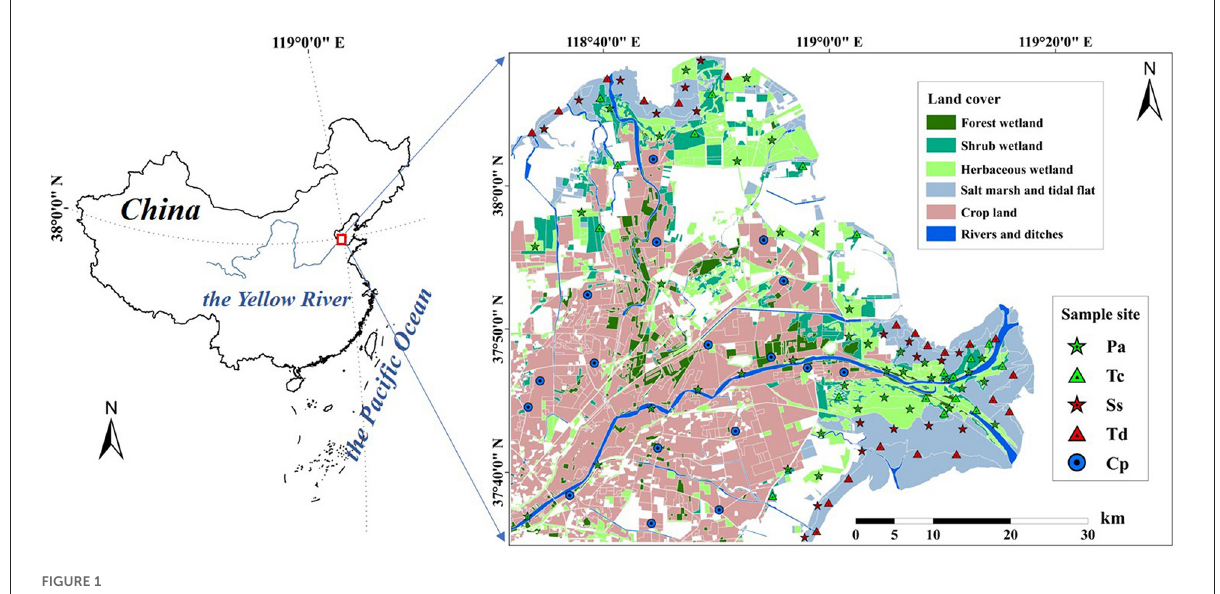
FIGURE1 Map of study area and sample